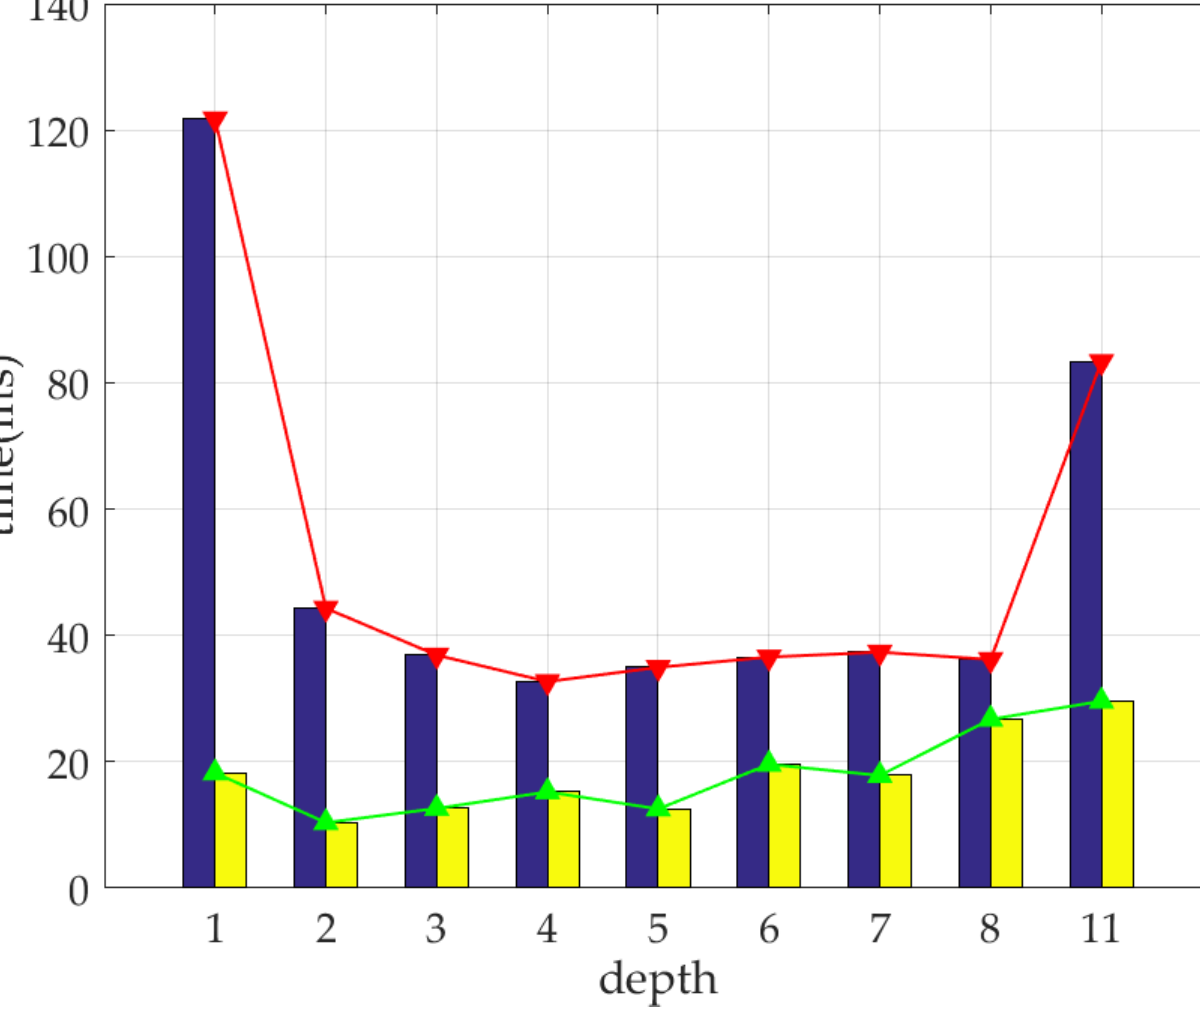
Figure 8. The effect of depth on octree constructing and kNN searching. The blue bars represent construction time, and the yellow bars represent kNN searching time, where k =